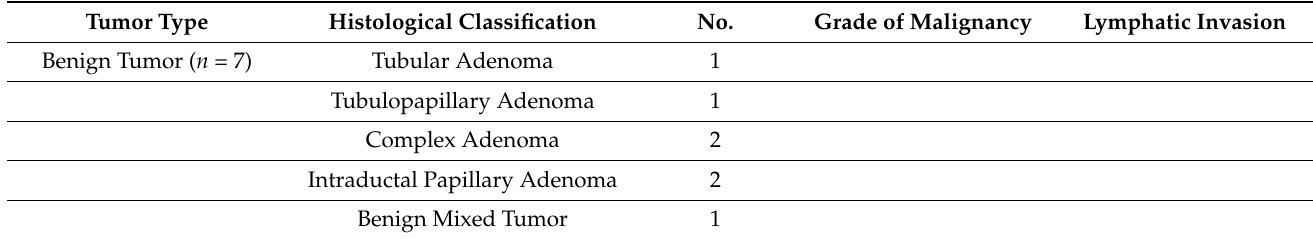
Table 1. Histological Classification and Grading for Canine Mammary Tumors. Tumor Type Histological Classification No. Grade of Malignancy Benign Tumor ( n =